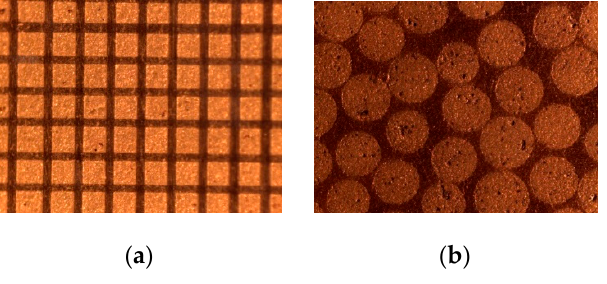
Figure 5. Microscopic image of the piezocomposite surface. ( a ): Dice and fill composite with 130 µ m square ceramic pillars, 48 µ m pitch and 70% ceramic volume fraction; ( b ): Random ceramic fibers composite with 250 µ m fiber diameter and 65% ceramic volume fraction.